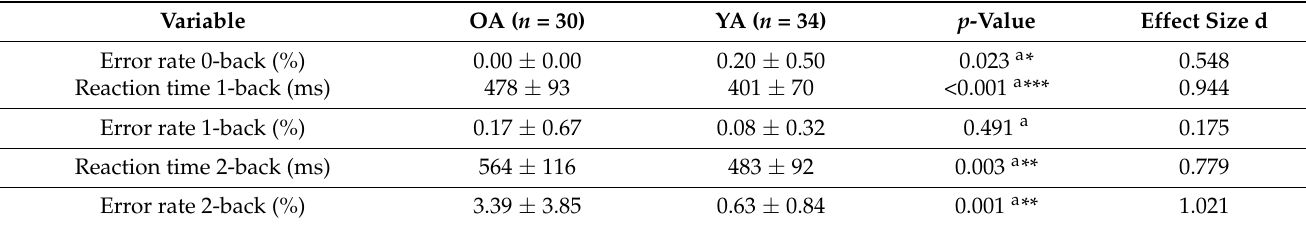
Table 2 and Figures 2–6 show the results of mHR and the HRV for both groups. mHR and HRV parameters were higher in YA compared to OA. Results of ANOVA indicated